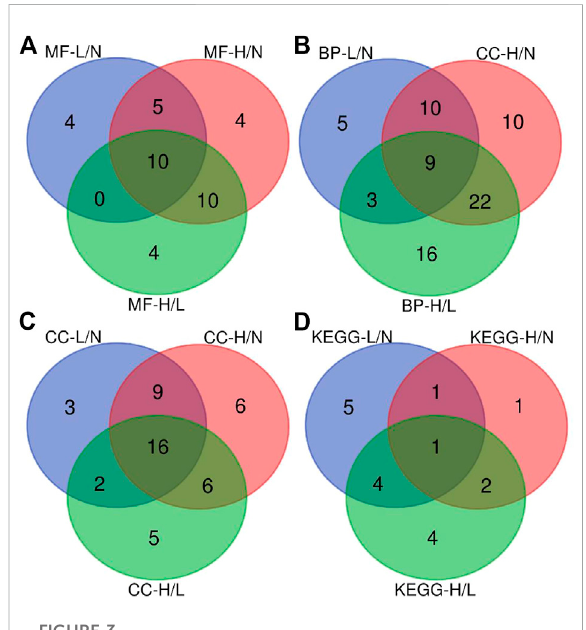
FIGURE 3 Venn diagram showing the overlap of the enriched biological pathways identi fi ed using GO and KEGG pathway databases. (A) , Venn diagram of the overlap of signi fi cant regulated molecular function categories; (B) , Venn diagram of the overlap of signi fi cant regulated biological process categories; (C) , Venn diagram of theoverlap of signi fi cant regulated cellular component categories; (D) , Venn diagram of the overlap of signi fi